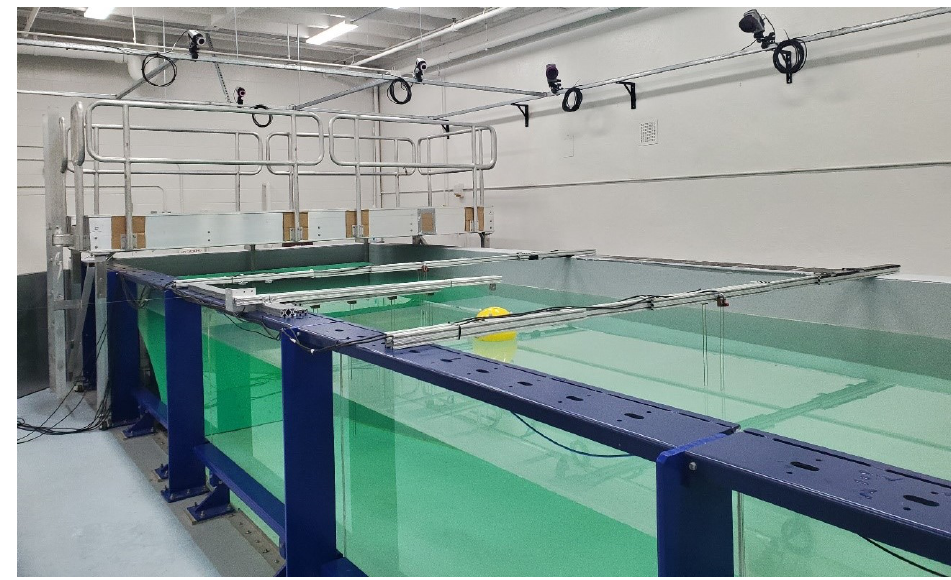
Figure 1. The Edinburgh Designs wave tank at Michigan Tech’s MWave Laboratory.